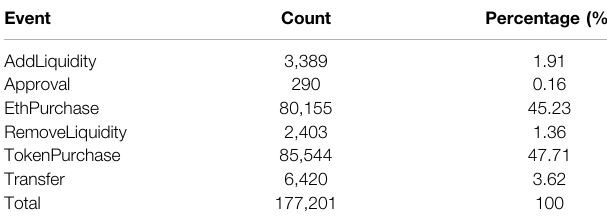
TABLE 1 | Absolute counts and probabilities of liquidity events. TABLE 2 | Uniswap trade classi fi er